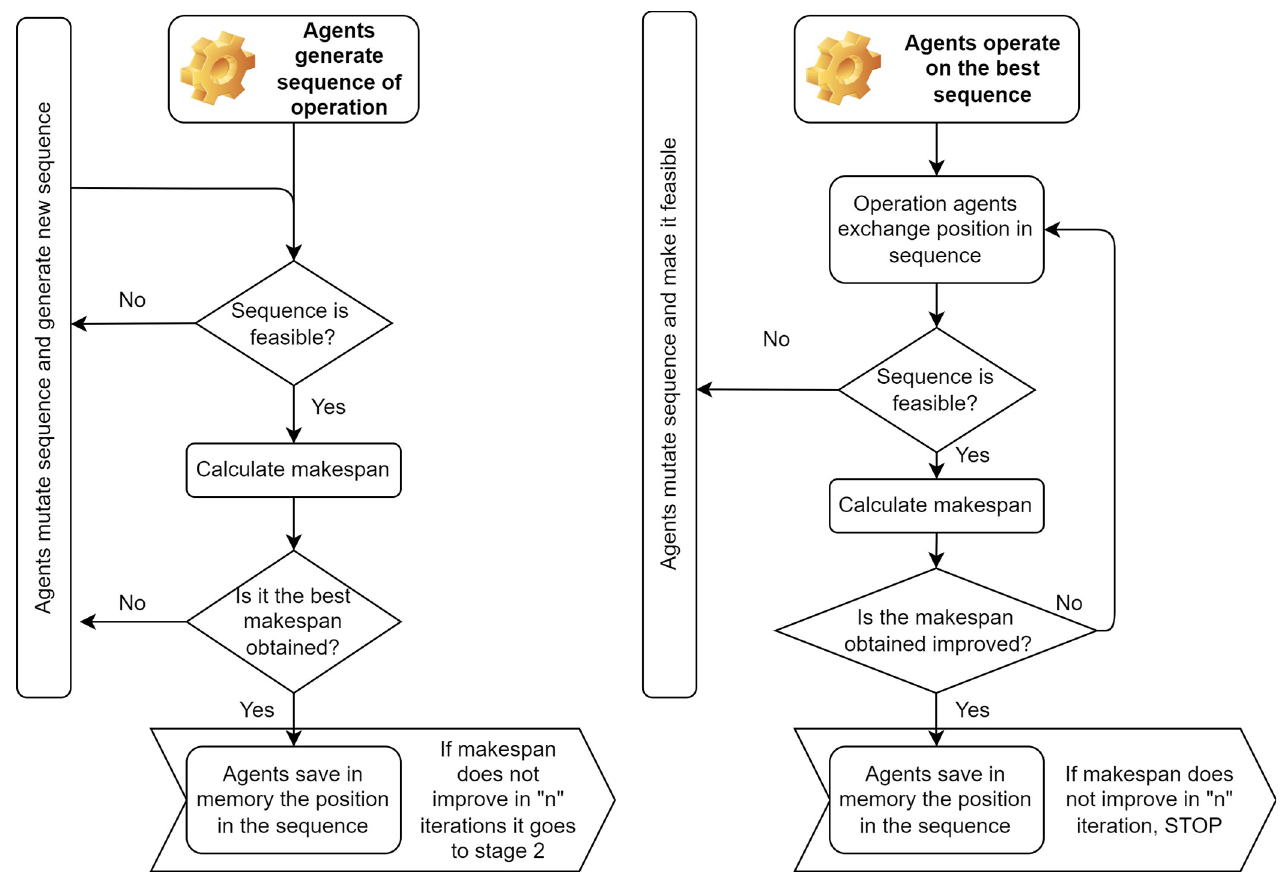
Fig 4. Flow diagram for the intelligent process in product